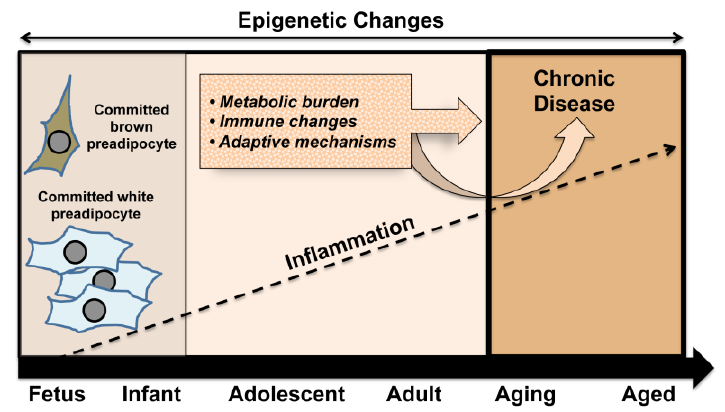
Figure 2. In a mutually reinforcing way, early set points in the developmental process, such as the balance between white and brown adipose tissue, act together with exposures across the lifespan to enhance metabolic burden and immune system changes. In concert with adaptive mechanisms, these conditions underpin an increased likelihood of developing chronic disease in later